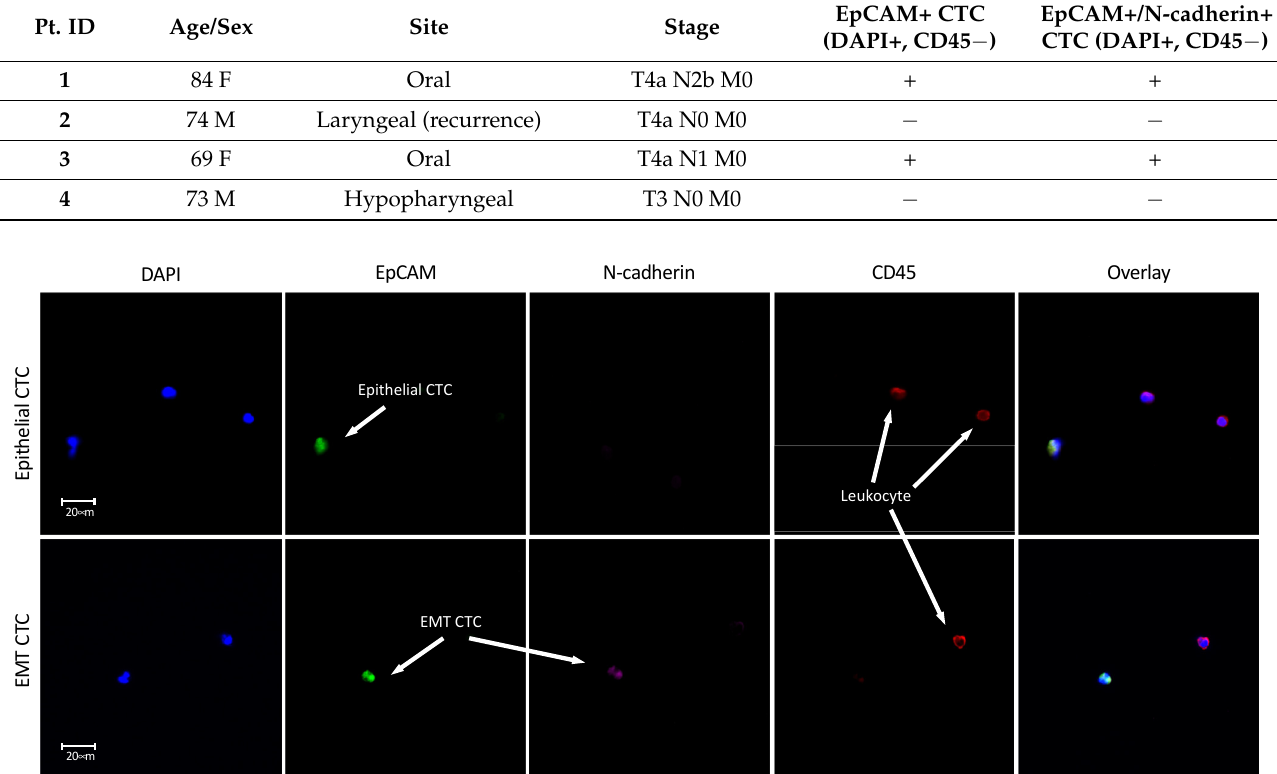
Table 3. Patient clinicopathological data and presence of CTCs. Cells that were DAPI-positive and CD45-negative with expression of CTC markers (EpCAM and/or N-cadherin) were identified in both patients 1 and 3, both of whom had advanced stage III/IV HNSCC with node positive disease. For both of these patients epithelial CTCs and epithelial-mesenchymal transitioning CTCs were detected.